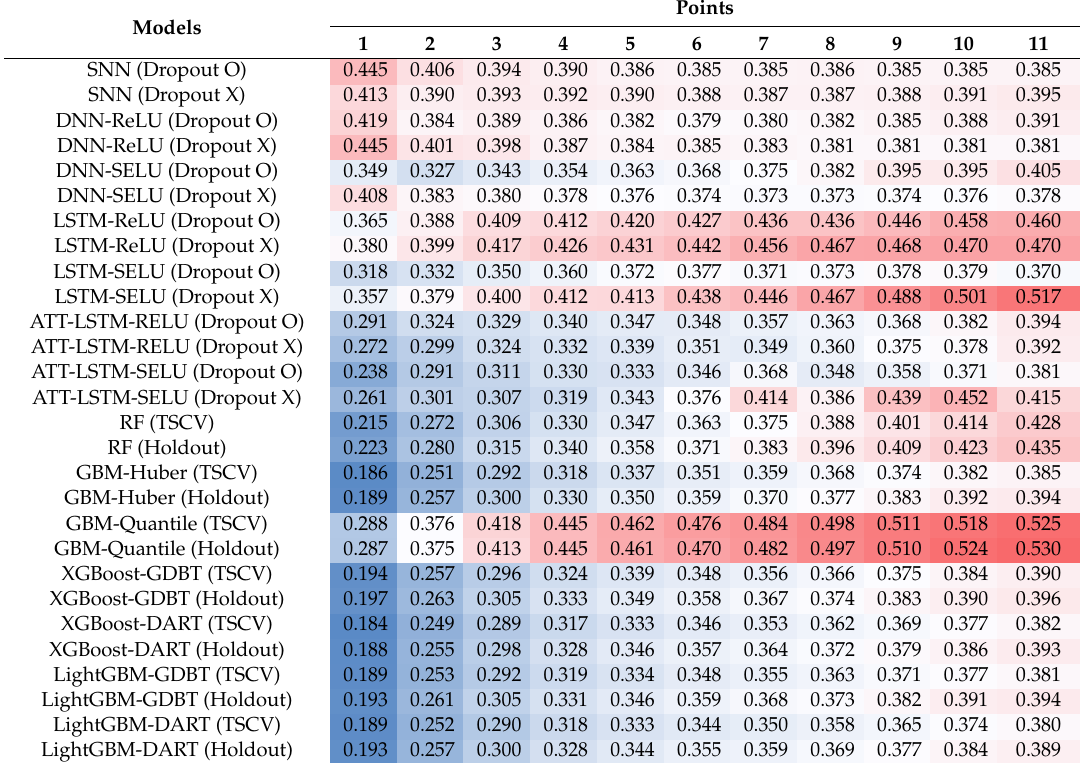
Table 6. Mean absolute error (MAE) distribution for each model for Ildo-1. A cooler color indicates a lower MAE value, whereas a warmer color indicates a higher MAE value (MJ/m 2